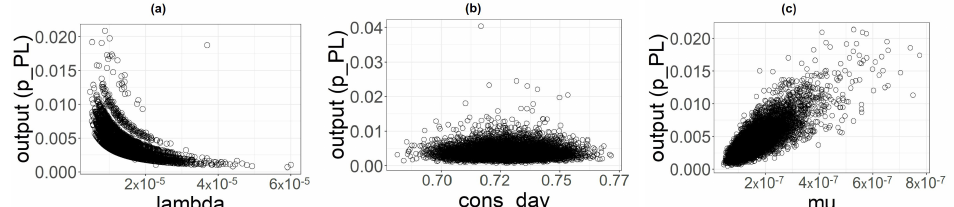
Figure 6. Scatterplot of input parameters for category PL versus the output considered ( p PL ). ( a ) λ PL . ( b ) cons PL ( c ) µ . day